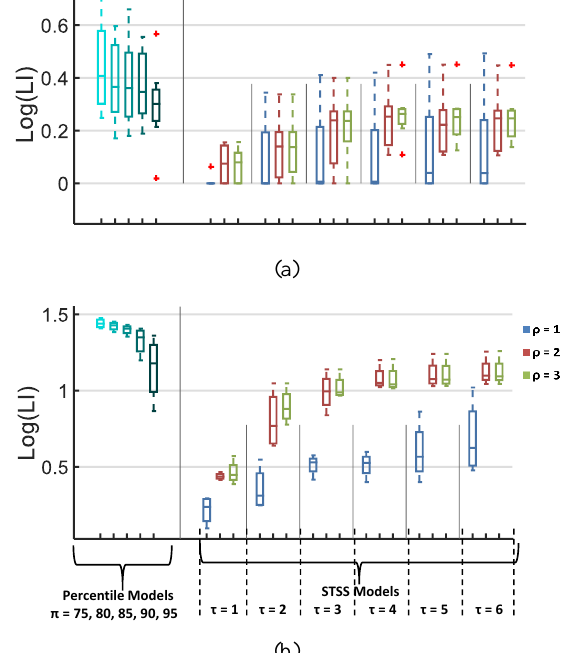
Figure 1. Variations of Localisation Index values of different NRC detection models on bank holidays (a) and tube strikes